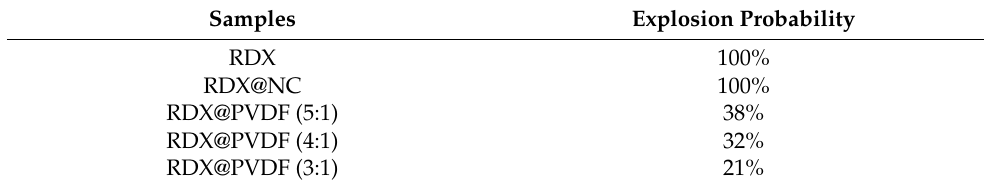
Table 3. The impact sensitivity results of samples. Samples Explosion